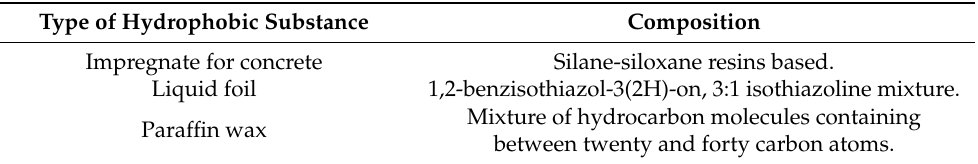
Table 3. Description of the used hydrophobic substances.